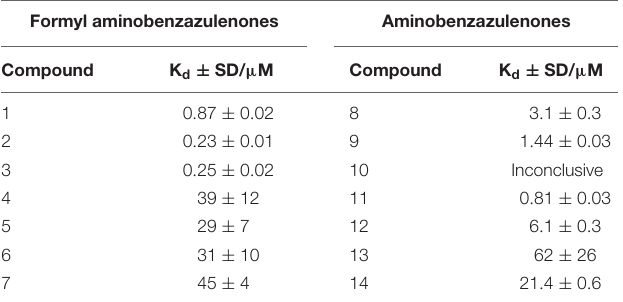
TABLE 2 | CaM-binding affinity of compounds after 24-h